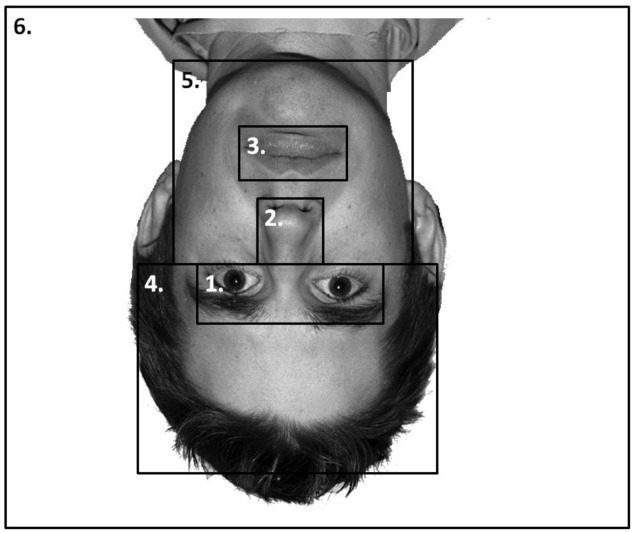
An example stimulus with the AOIs mapped onto it: (1) Eyes; (2) nose; (3) mouth; (4) forehead; (5) chin and cheeks; and (6) the rest of the screen. AOIs were not visible to the participants.